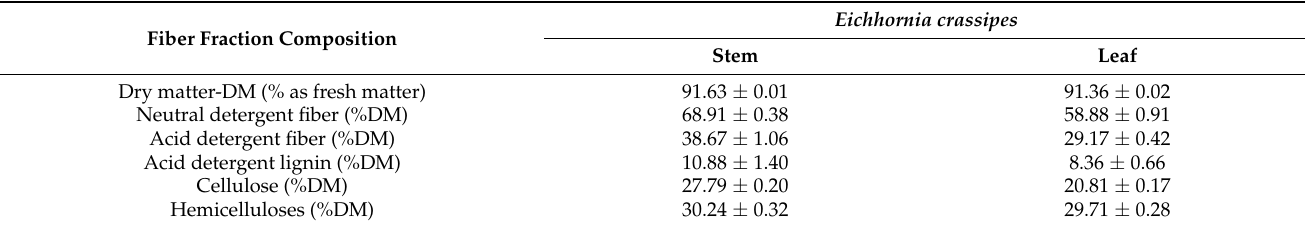
Table 1. Mean and standard deviation ( ± SD) of fiber fraction composition (triplicate) of stem and leaf of Eichhornia crassipes (water hyacinth).